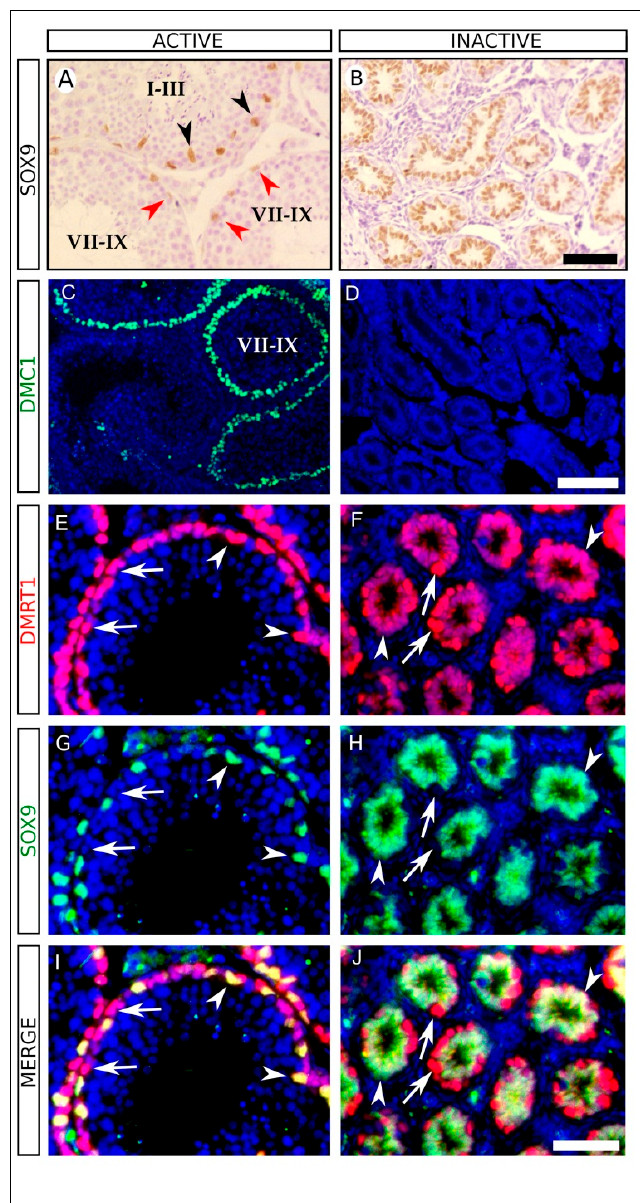
Figure 2. Immunohistological analysis for several Sertoli and germ cell-specific molecular markers in testis sections from M. duodecimcostatus captured in the wastelands. ( A , B ) Immunohistochemistry for SOX9. In winter ( A ) Sertoli cell expression of SOX9 is stronger in stages I-IV (black arrowheads) and weaker in stages VII-X (red arrowheads). However, in summer ( B ) SOX9 expression is strong and uniform in all Sertoli cells. ( C , D ) Immunofluorescence for DMC1. In winter ( C ) DMC1 is expressed in testis tubules in the spermatogenic-stages VII-IX. In contrast, no expression for DMC1 was observed in the summer ( D ). ( E – J ) Double immunofluorescence for DMRT1 (red) and SOX9 (green). In winter, DMRT1 is expressed in spermatogonial cells (arrows) and in Sertoli cells (arrowheads), where it colocalizes with SOX9. Note that, inside the tubules, there are many SOX9 − DMRT1 - cells corresponding to germ cells in more advanced stages of the spermatogenic cycle ( E , G , I ). In summer, SOX9 + , DMRT1 + Sertoli cells fill almost the entire inner part of the tubules (arrowheads), and SOX9 − , DMRT1 + spermatogonial cells located at basal positions (arrows) can also be observed ( F , H , J ). No SOX9 − , DMRT1 - cells was observed inside of the tubules ( F , H , J ). Testes sections in ( C – J ) were counterstained with DAPI. Scale bar shown in ( B ) represents 50 µ m for ( A , B ). Scale bar shown in ( D ) represents 100 µ m for ( C , D ). Scale bar shown in ( J ) represents 50 µ m for ( E – J